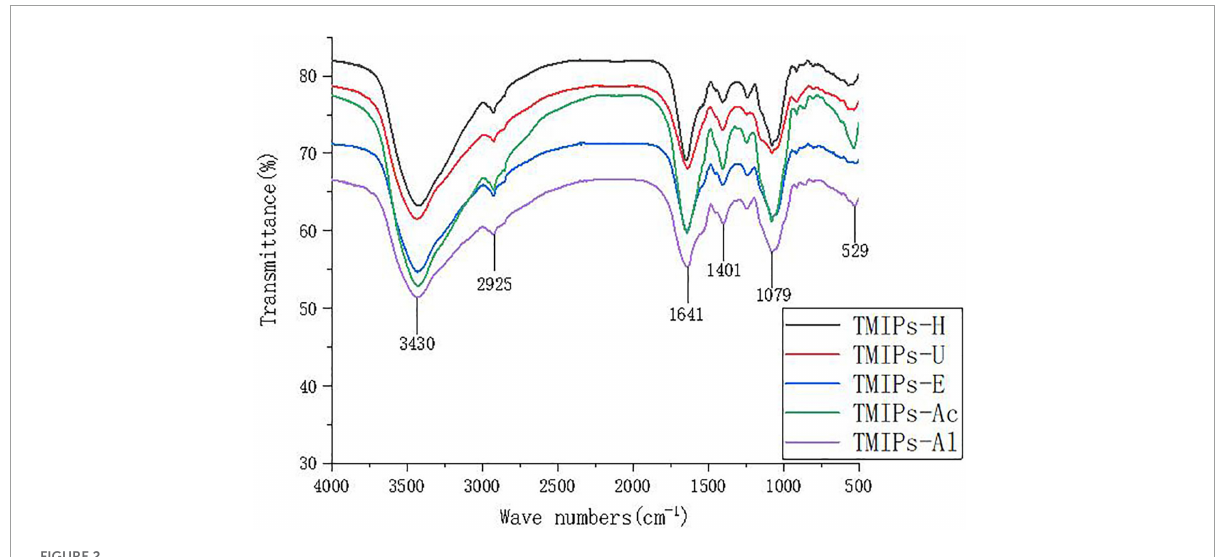
FIGURE2 The FT-IR spectrum of